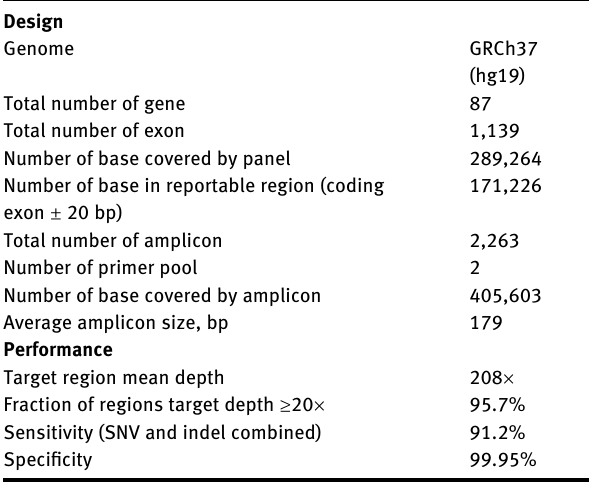
Table  : Summary of panel design and